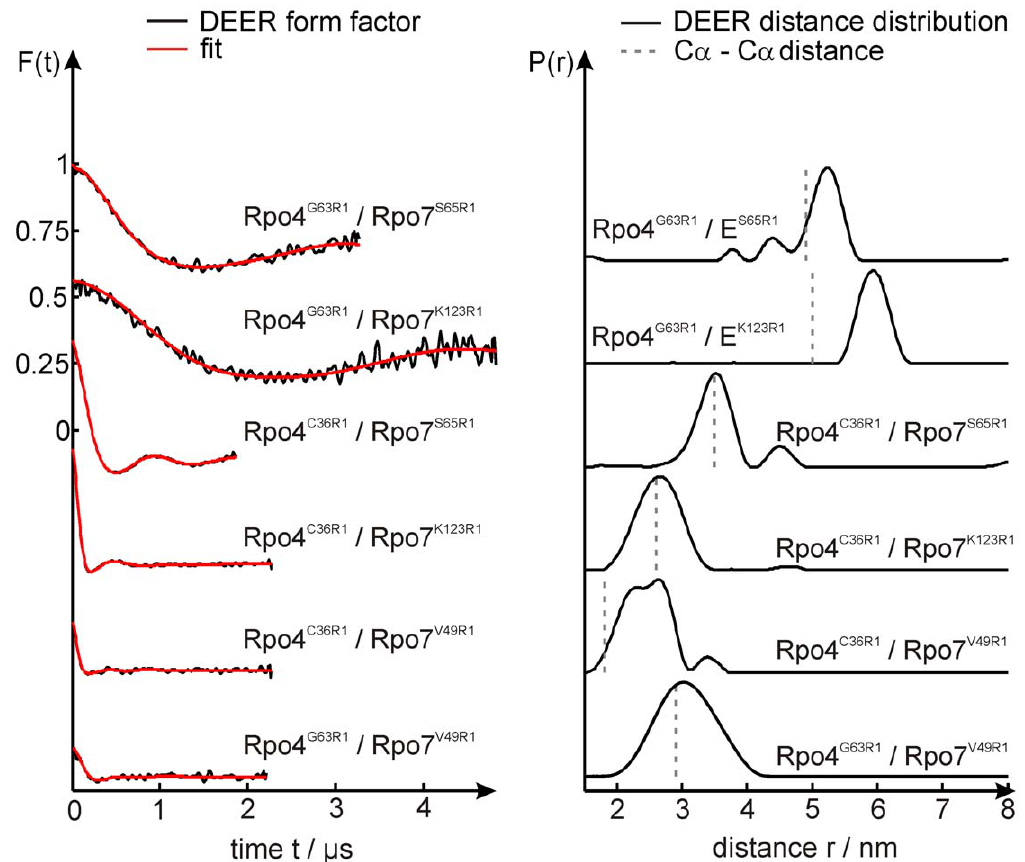
Figure 3. DEER data and distance distributions of doubly spin-labeled Rpo4/7 complexes. Left: background corrected dipolar evolution data; right: distance distributions obtained by Tikhonov regularization. Red traces in the left panel represent the fits obtained by Tikhonov regularization. In the distance distributions C a -C a distances derived from the Rpo4/7 crystal structure (pdb: 1GO3) are indicated by gray dashed lines.